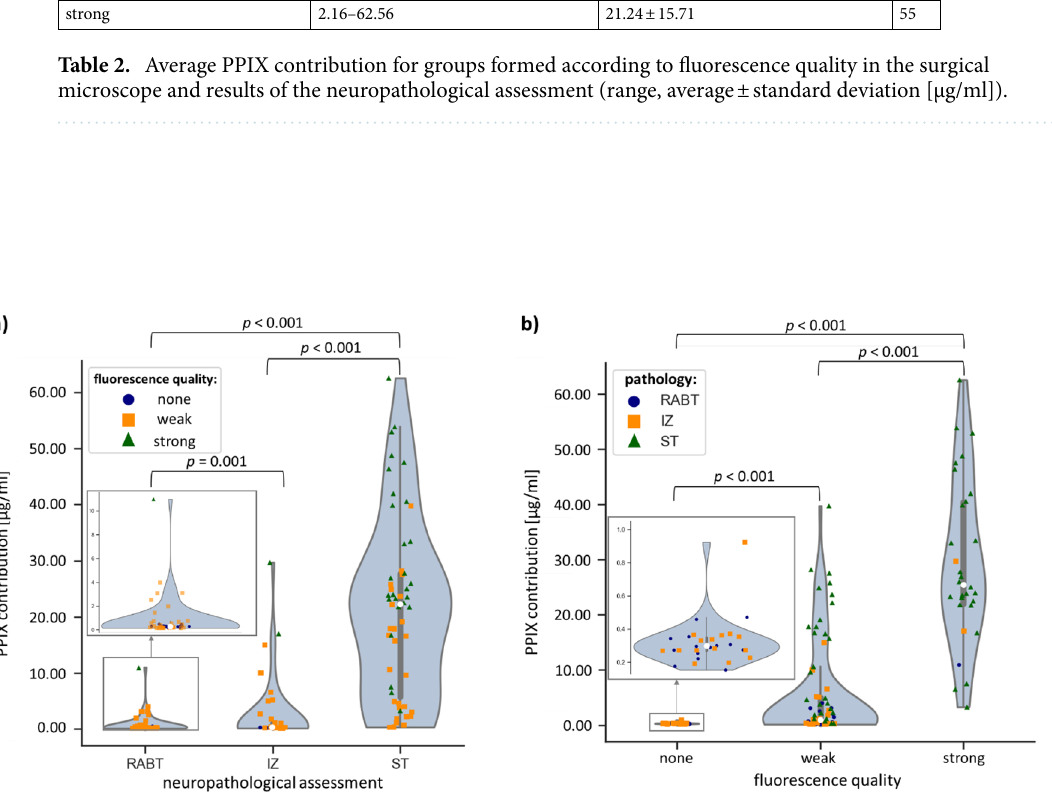
Table 2. Average PPIX contribution for groups formed according to fluorescence quality in the surgical microscope and results of the neuropathological assessment (range, average ± standard deviation [µg/ml]).